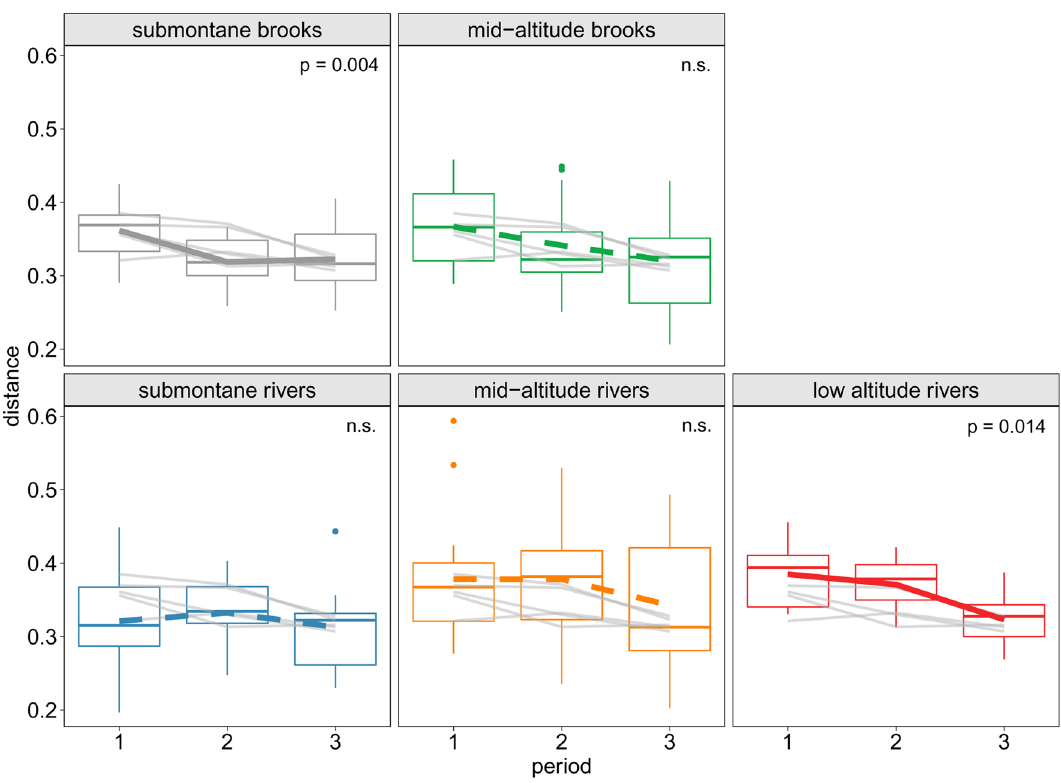
Figure 3. Beta-diversity of macroinvertebrate assemblages in the 65 repeatedly sampled stream sites in 1997–2000 (period 1), 2007–2008 (period 2) and 2015 (period 3). Streams were divided into five types along a river continuum to be analysed separately. Beta-diversity of each group was counted as mean distance of sites to the group centroid created by principle coordinate analysis (PCoA), using Bray–Curtis dissimilarities of ln(x + 1) transformed abundance data. Homogeneity of multivariate dispersions in the three periods was tested using one-way ANOVA. n.s.— p > 0.05.